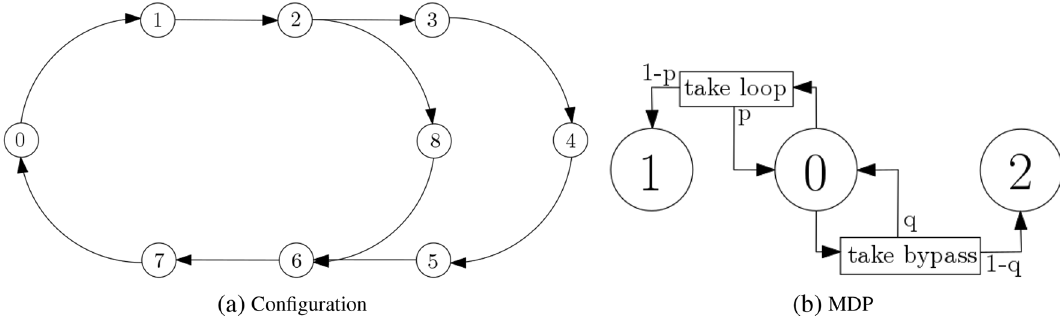
Figure 4. ( a ) Discrete two-train configuration. ( b ) MDP representation of the agent in its world. Circles represent states. Arrows represent action-triggered